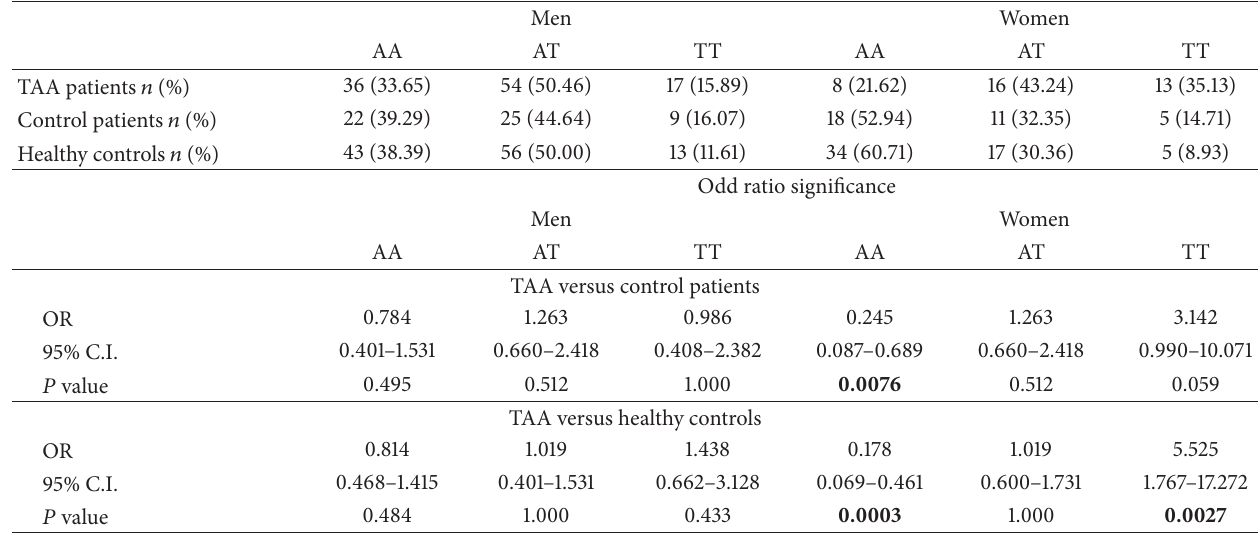
Table 6: Statistical analysis of TGF- 𝛽 2 rs900 genotype distributions in patients affected by TAA and in the two groups of control subjects stratified according to the gender ∗